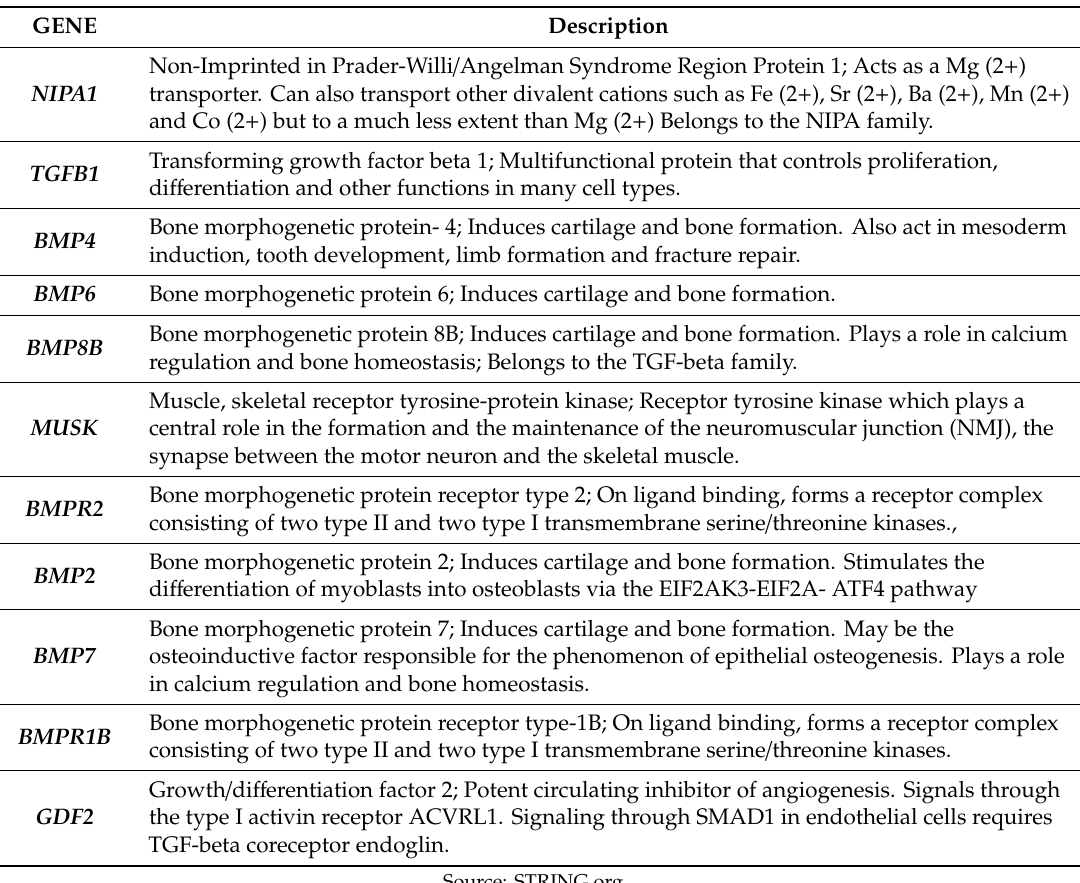
Table 5. STRING Interactants and Their Functions Related to Other Proteins Associated with NIPA1